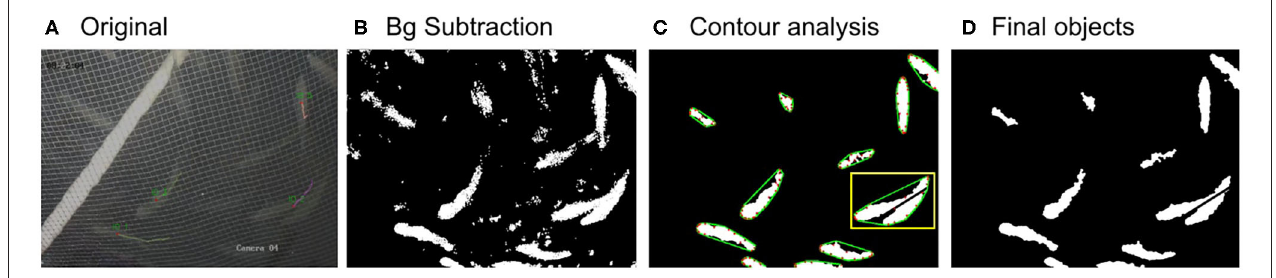
FIGURE 3 | Images showing the original image frame (A) , the extracted foreground image (B) , the image after filtering out noise and running contour analysis (C) , and the final image with the detected objects (D) . In image (C) , the defect points are shown in red and the convex line in green. The yellow rectangle indicates a case of two overlapping fish and their